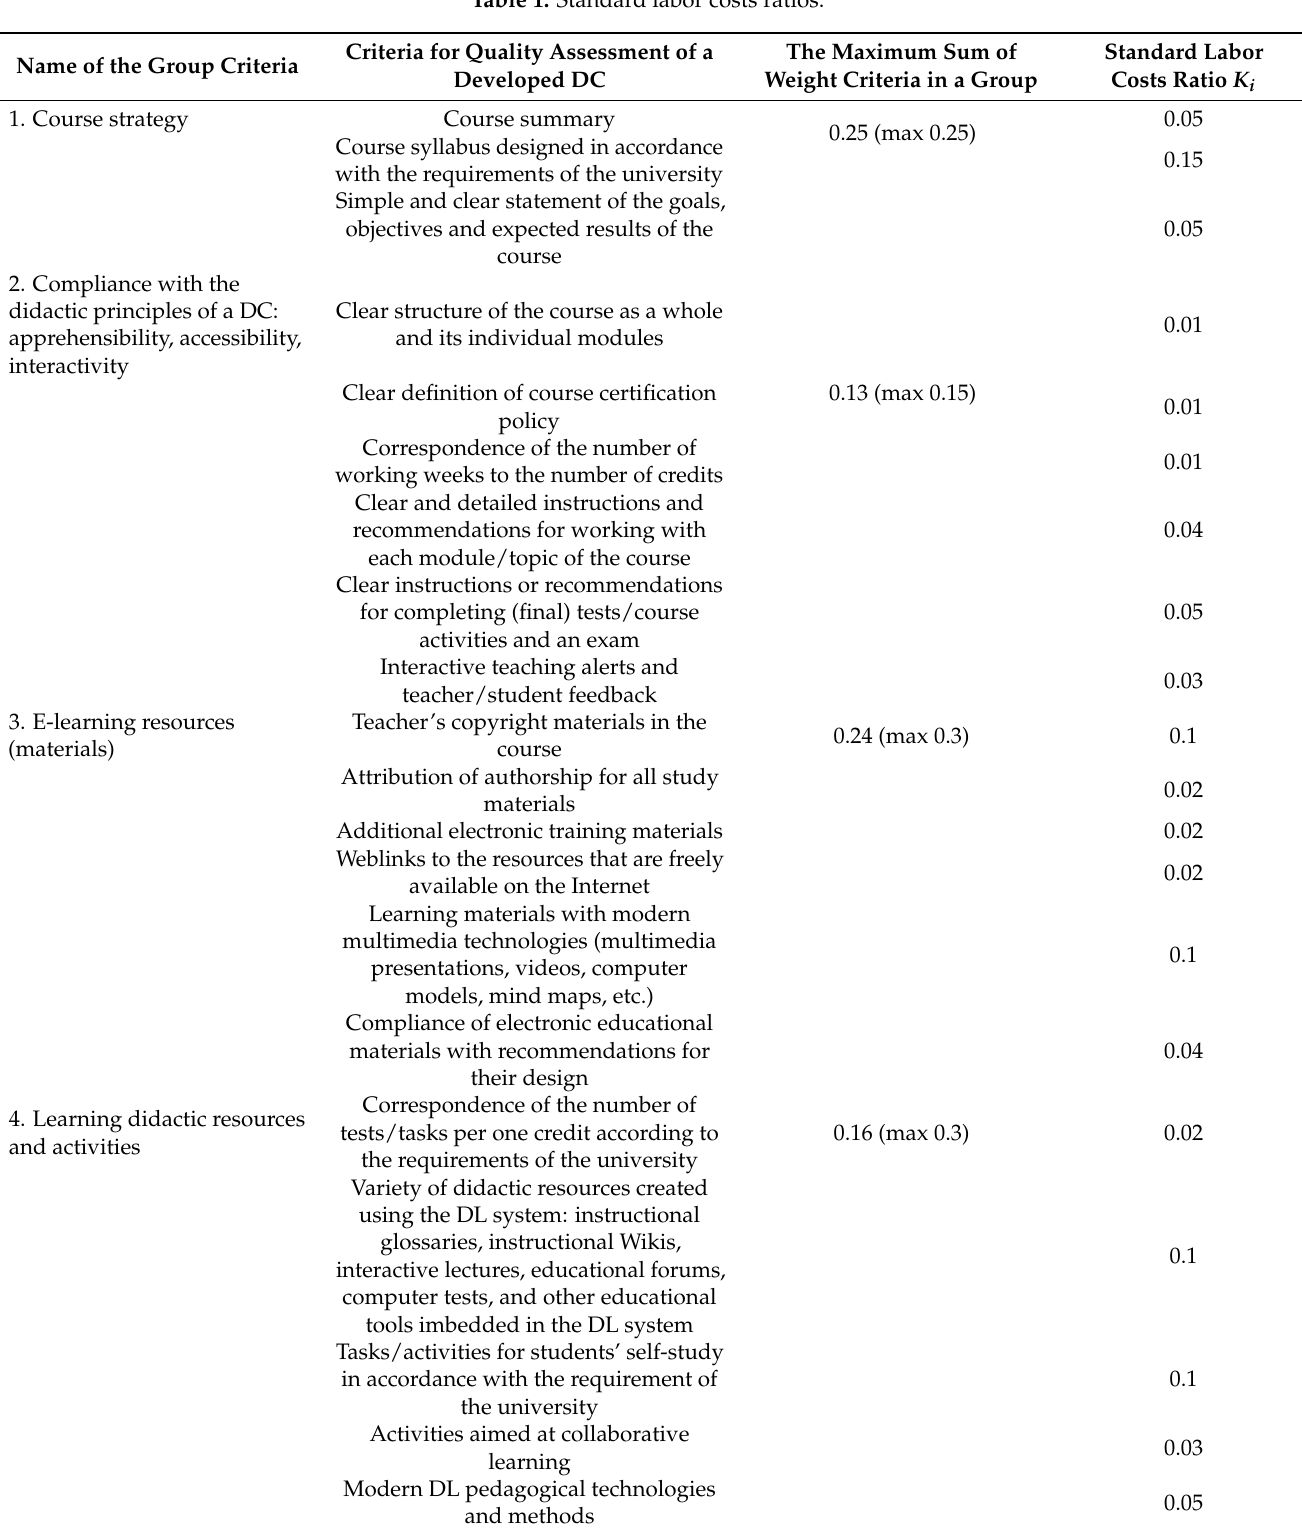
Table 1. Standard labor costs